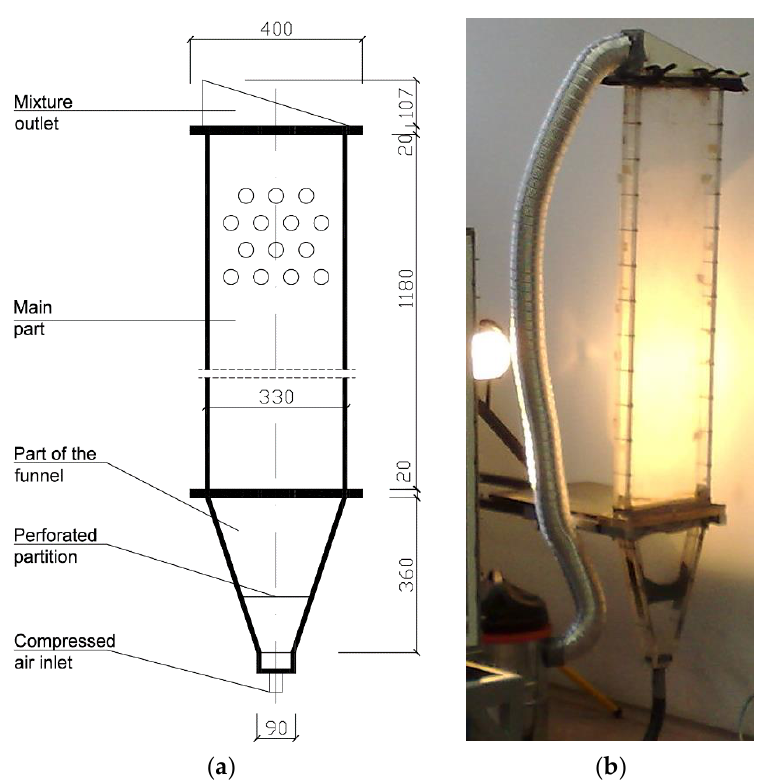
Figure 2. Two-dimensional (2D) test installation: ( a ) dimensional drawing; ( b ) view.